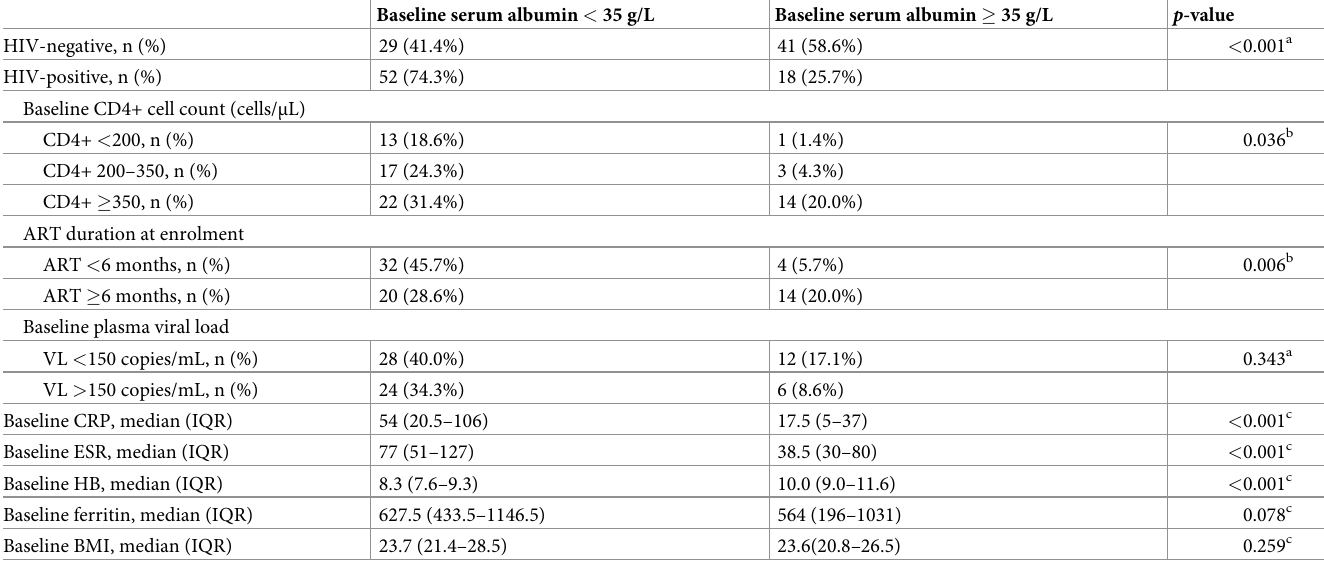
Table 2. Baseline characteristics according to serum